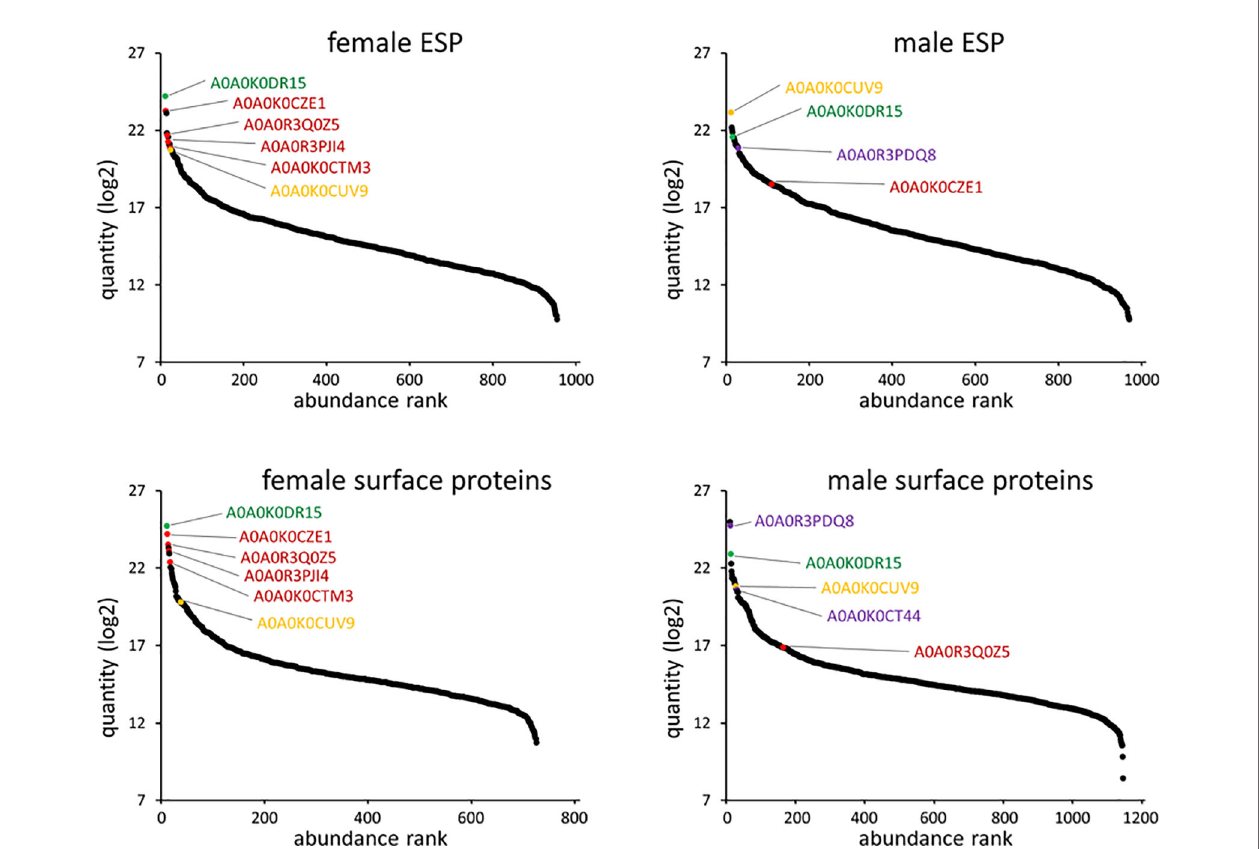
FIGURE 4 | Angiostrongylus vasorum female and male protein abundance distribution for ESP and surface proteins. Identi fi ers that are further discussed or were used for surface immunolocalization are highlighted. A0A0K0CZE1, A0A0R3Q0Z5, A0A0R3PJI4, A0A0K0CTM3 (orthologue description ‘ von Willebrand factor type D domain protein ’ ; red); A0A0R3PDQ8, A0A0K0CT44 (orthologue description ‘ major sperm protein ’ ; purple); A0A0K0DR15 (orthologue description ‘ nematode fatty acid retinoid binding protein ’ ; green); A0A0K0CUV9 (orthologue description ‘ enolase ’ ;